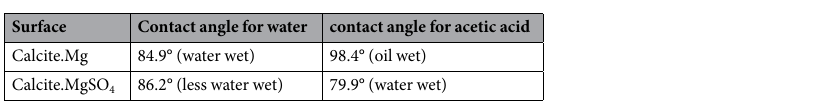
Table 3. Change in contact angle for Solid-Liquid-Vapor (SLV) phases by considering 10% of wettability alteration due to additive ions of sea water and ideal case for initial mixed oil wet calcite surface, θ =